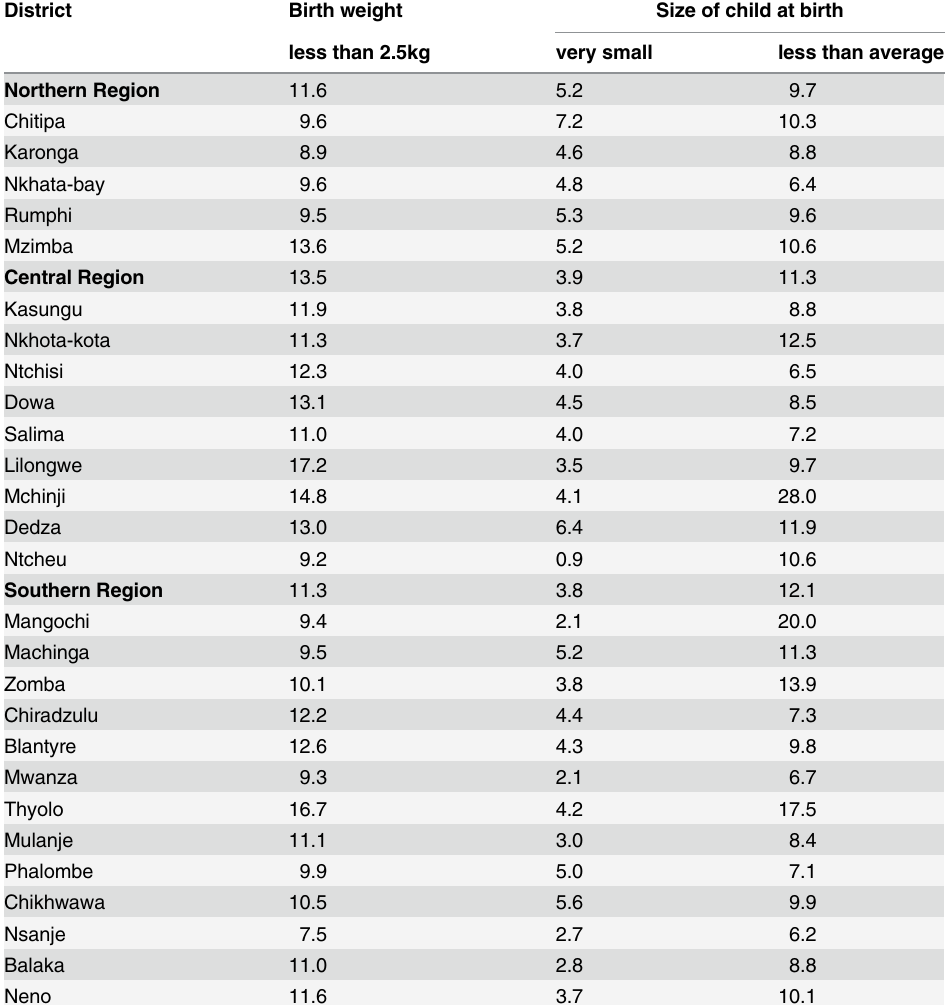
Table 2. District percentage distribution of birth weight and size at